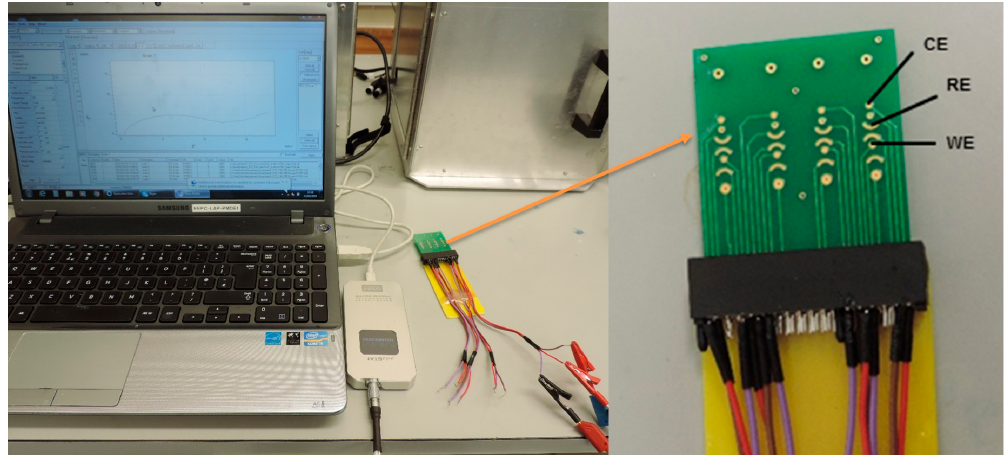
Figure 2. Illustration of the electrochemical impedance spectra (EIS) measurement setup using a pocketstat with a commercially fabricated printed-circuit-board (PCB). Inset shows a magnified view of a PCB in a three-electrode configuration.